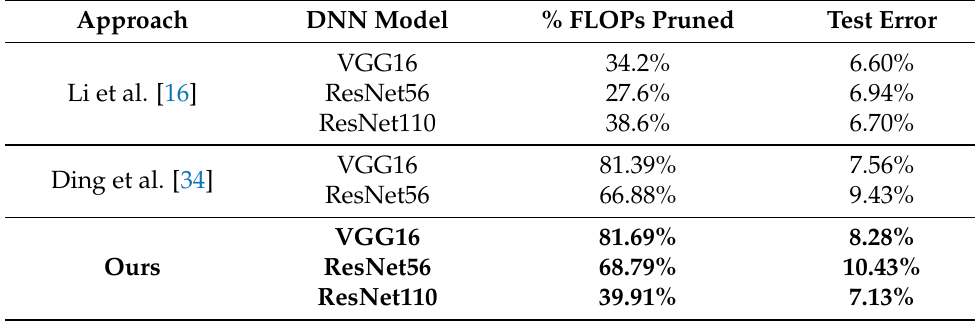
Table 4. Pruning results from peer competitors using the CIFAR10